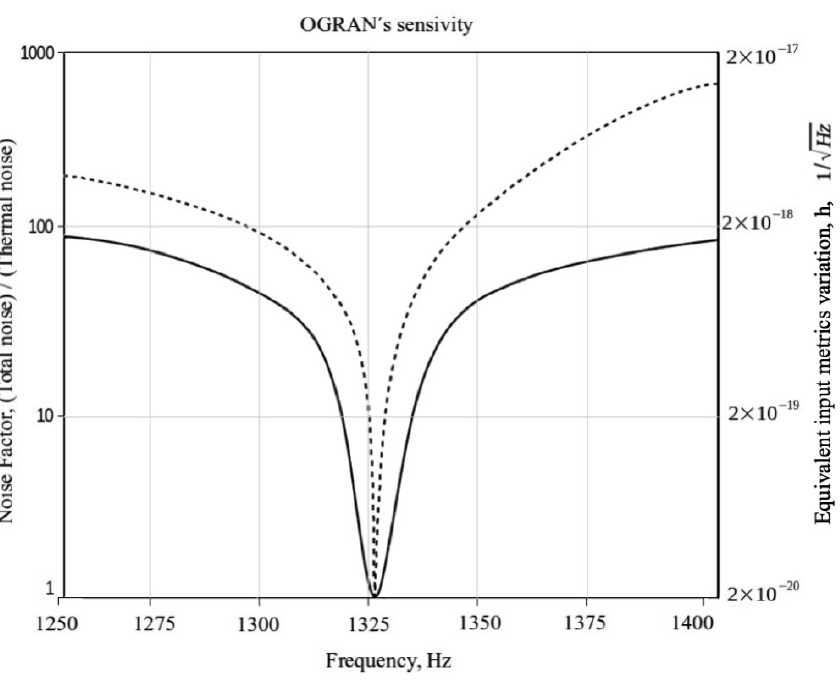
Figure 2. Noise spectral density of the OGRAN antenna (from [11]). Doted line—the experimental curve of old version of the setup F ∼ 2000; normal line—the curve of modernized setup F ∼